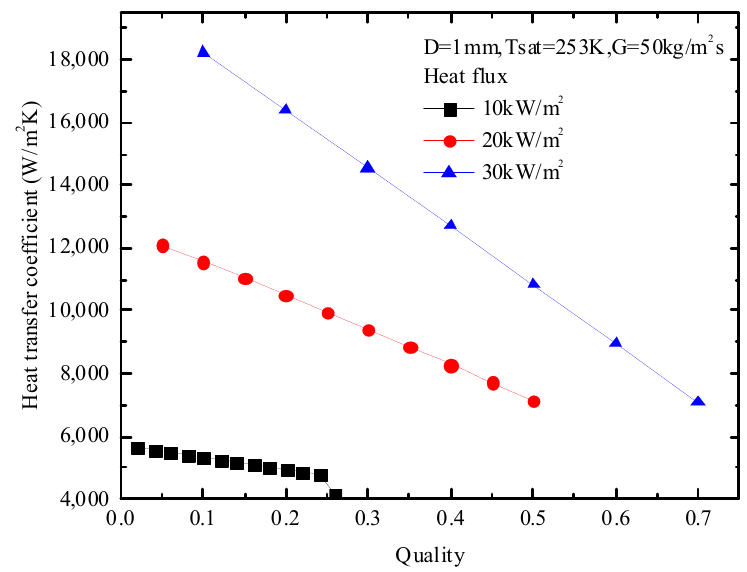
Figure 12. Effect of heat flux on heat transfer coefficient of R744.